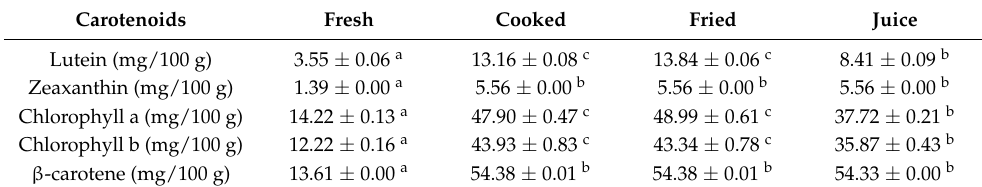
Mean values ± SD ( n = 3) marked by different letters in the same line differ significantly (Duncan’s test, p ≤